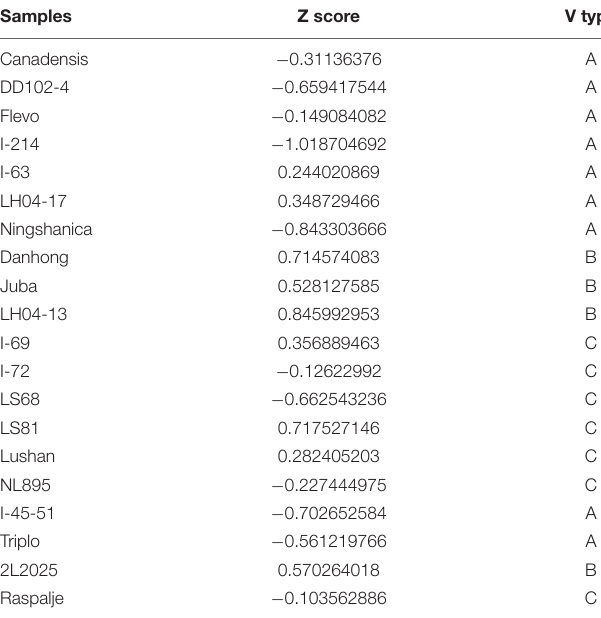
TABLE 5 | Main information of poplar